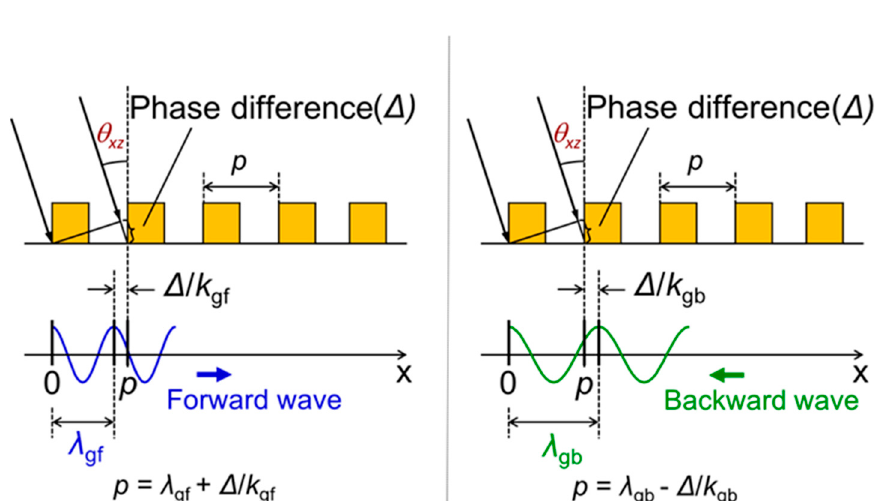
Figure 4. Phase matching conditions between the diffracted wave from antenna surface and the waveguide mode in the SOI layer for forward and backward waves reproduced from [22]. k gf = 2 π / λ gf and k gb = 2 π / λ gb are the wavenumbers for forward and backward waves, respectively. In the case of y -direction, θ yz is considered instead of θ xz .